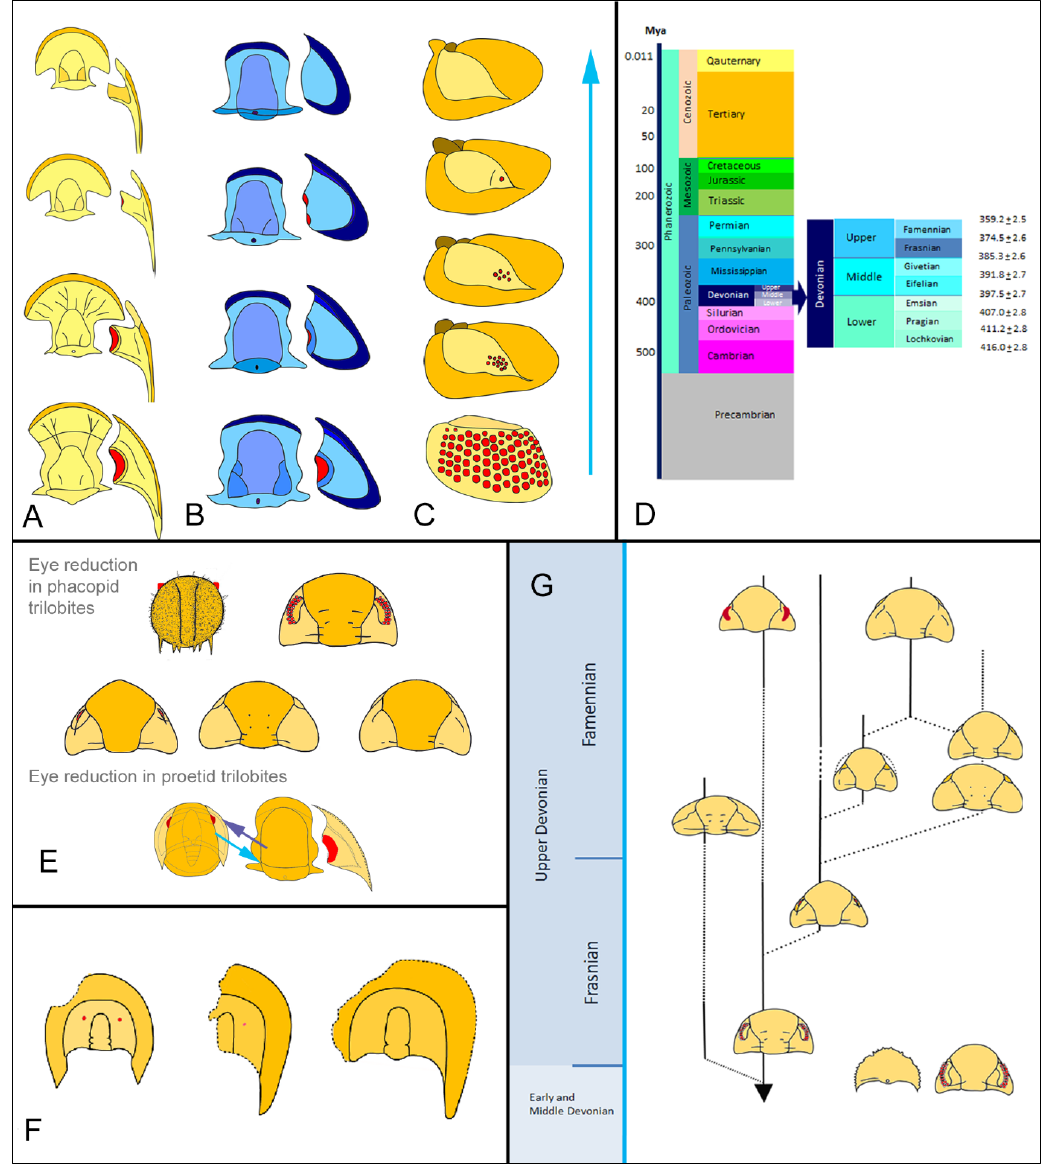
Figure 3. Eye reduction and blindness in some parallel Devonian trilobite lineages. (A) Tropidocoryphinae (Proetida), Givetian-Frasnian, with unidirectional morphological change and eye reduction. (B) Palpebralia (Proetida), Frasnian, showing progressive eye reduction. (C) Cryphops (Phacopida), base: typical phacopid eye, upwards: progressive eye reduction. (D) Geological time scale. (E) Eye shifting paedomorphically to the front in phacopid trilobites and ontogentic change of eye position during ontogenetic development in proetid trilobites. (F) Harpes neogracilis (Harpetida), Late Frasnian, in this species eyes are reduced, while the cephalic rim enlarges to a 'compound nose' rsp. 'compound ear'. (G) Eye reduction in Late Devonian lineages (comp. Feist 1995), Cyrtosymbolinae, Famennian, progressive eye reduction. (A, E-G) after Feist 1995, (B, C) after Feist 1991, (D, H) after Feist and Schindler